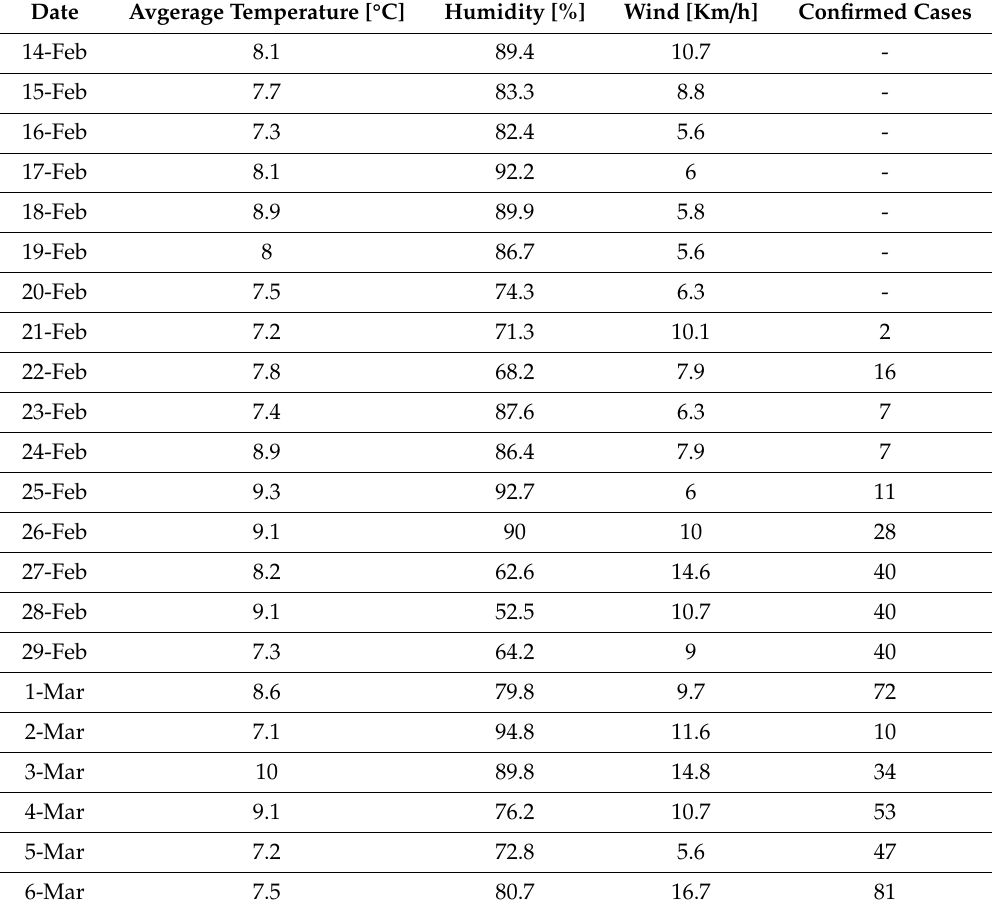
Table A2. The dataset of Veneto (Venice),